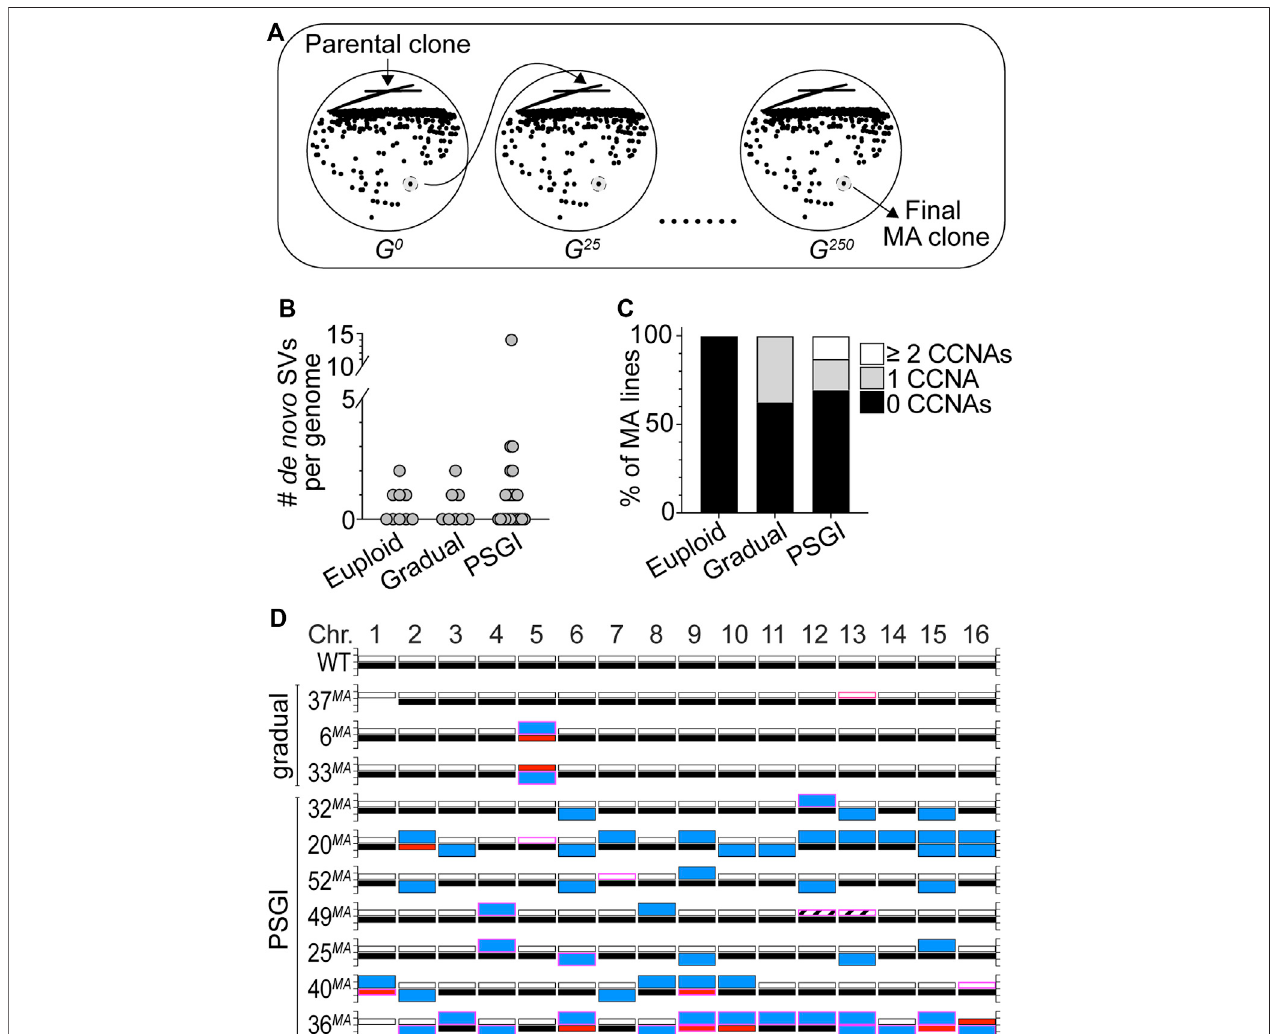
FIGURE3 | Phenotypic variants display long-term genomic stability. (A) Acartoon schematic outlining themutationaccumulation studyperformed on euploid and variantclones. (B) .Thenumberof denovo SVsharboredbythedelineatedsubsetsofterminalMAlines. (C) .ThepercentageofMAlinesharboringthedenotednumbers of denovo CCNAs.Foreachsubset,mediannumberof denovo SVsequalszero. (D) .KaryotypesoftheMAlinesderivedfromgradualandPSGI-typevariantclonesthat acquired de novo CCNAs over the course of the experiment. Bars outlined in pink denote de novo CCNAs that arose during the MA study. Bar colors same as in Figure 2